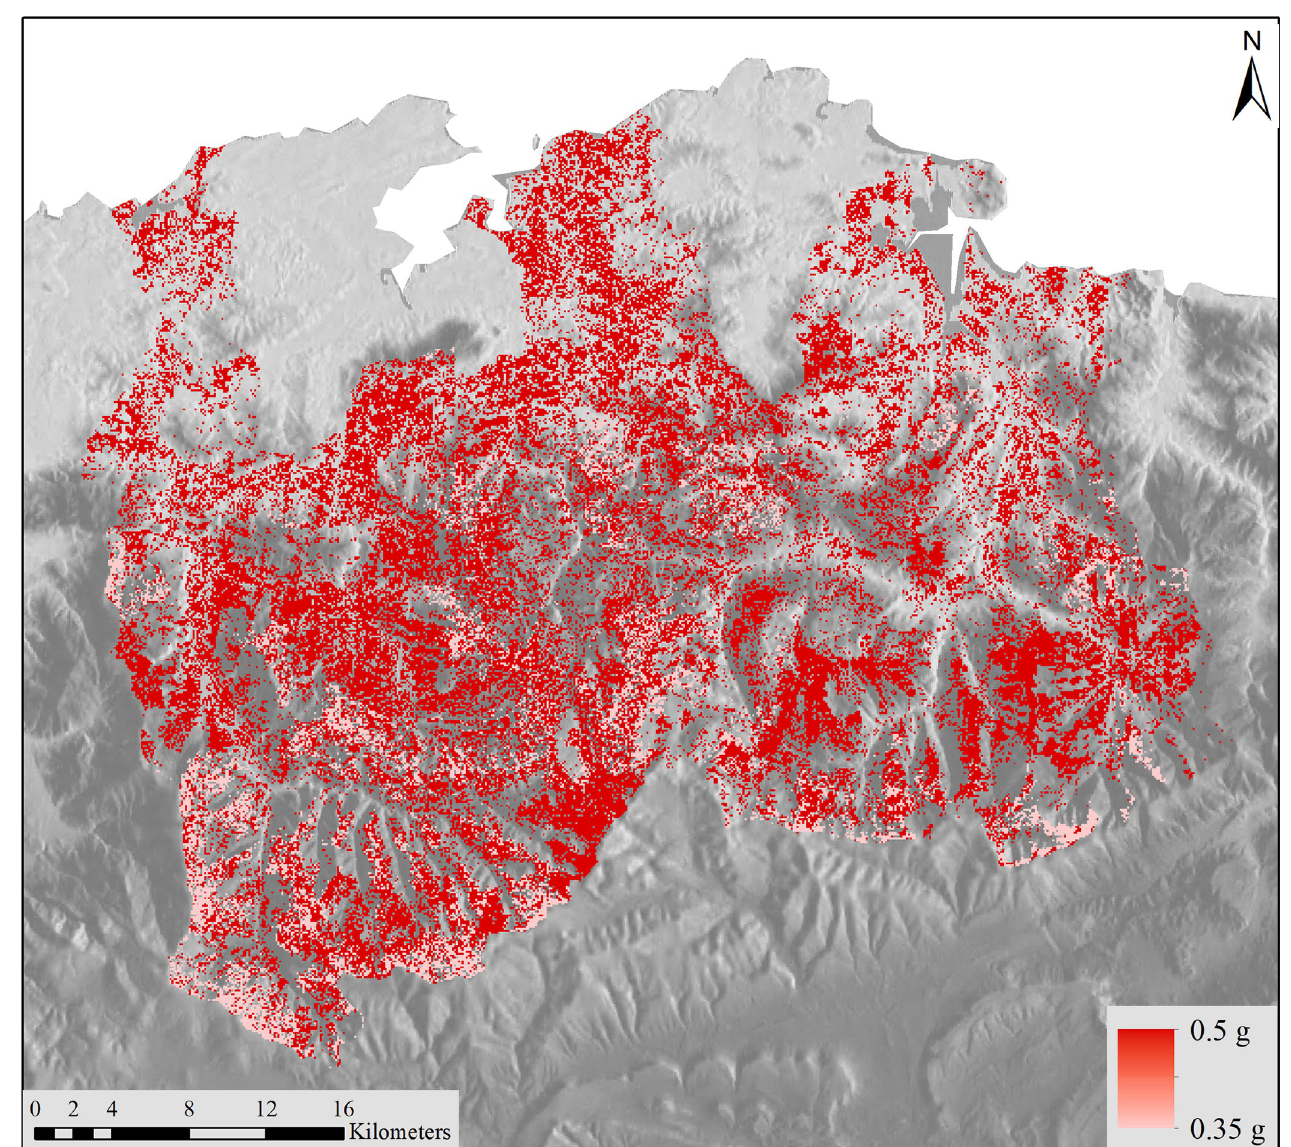
Fig 11. Nitrogen leaching output model in grams of nitrogen mass. Reprinted from [67] under a CC BY license, with permission from ISPRS Journal of Photogrammetry and Remote Sensing, original copyright 2014.